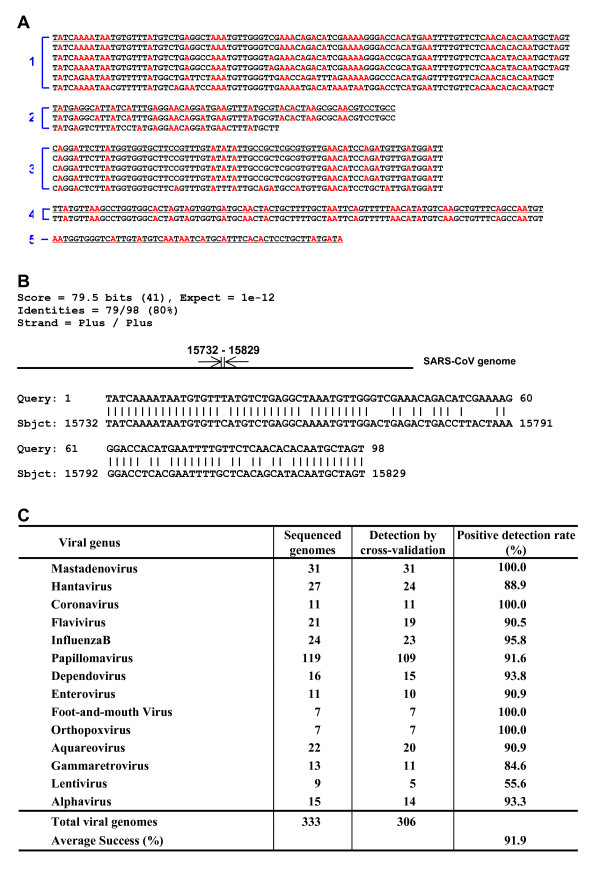
In silico validation of the conserved sequence design method. All of the fully sequenced viral genomes (except that of SARS-CoV) in the coronavirus genus were used to determine the conserved sequences. The design method was validated by testing if the computed conserved sequences could successfully detect the novel SARS-CoV. (A) The redundant conserved segments as computed by steps 1 to 4 of the probe design algorithm were reduced to five nonredundant sequence groups by the BLASTN sequence alignment in step 5 of the probe design algorithm. The longest sequence (underlined sequence) in each group was used to represent the group. (B) BLASTN results for the comparison of the group 1 conserved sequence with the SARS-CoV genome. The BLASTN alignment outputs are shown in the figure. The sequence alignment with the SARS-CoV genome shows that the group 1 conserved sequence is located between nucleotides 15732 and 15829 of the SARS-CoV genome. (C) Larger-scale cross-validation of 14 viral genera consisting of 333 nonredundant sets of viral genomes.